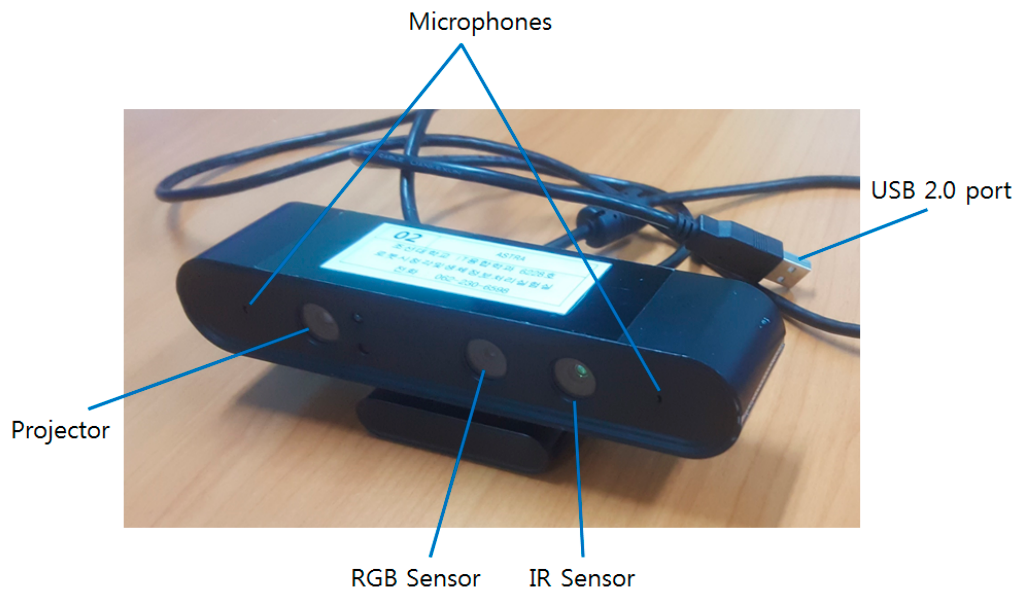
Figure 7. Astra camera for capturing posture images. RBG, red, blue, green; USB, Universal Serial Bus.